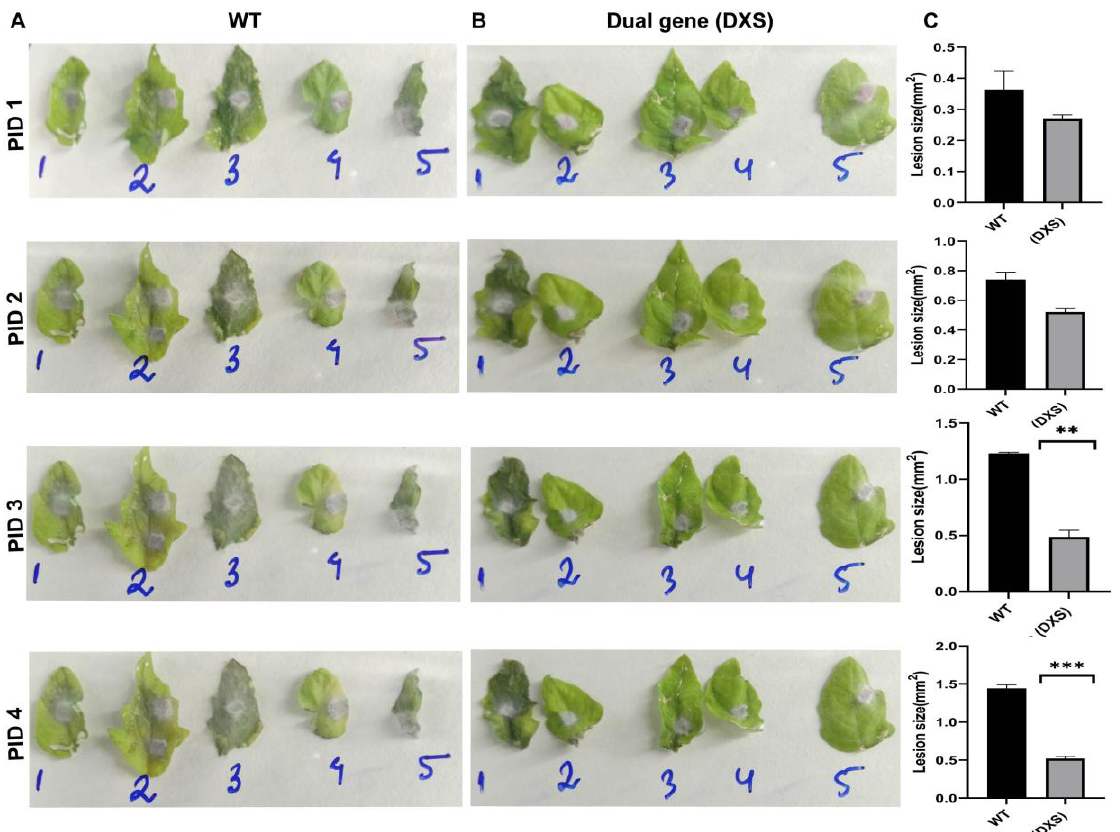
Figure 2. Sanger sequencing confirmation of single and dual-gene DXS CRISPR editing events of Fol 1322 tolerant leaves of tomato. Insertion (+), deletion ( − ), substitution (s). ( A ) Leaf 2 of XSP10 , Leaf 2 and 3 of SlSAMT . ( B ) Leaf 4, 5 of dual-gene editing of XSP10 and SlSAMT . ( C , D ) SX: Single- gene editing of XSP10 , SS: Single-gene editing of SlSAMT , DXS: Dual-gene editing of XSP10 (DX) and SlSAMT (DS).